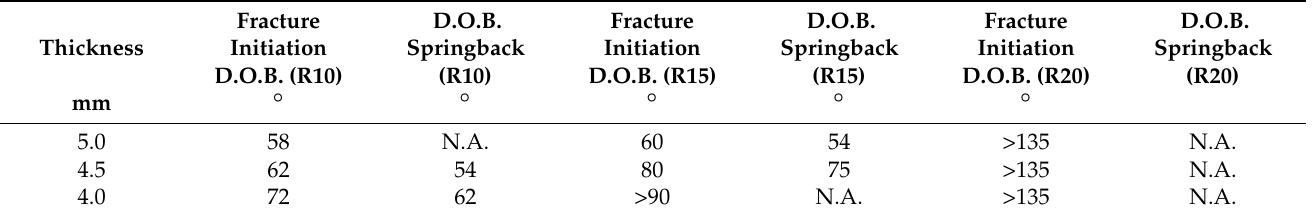
Table 3. FEM simulation results.